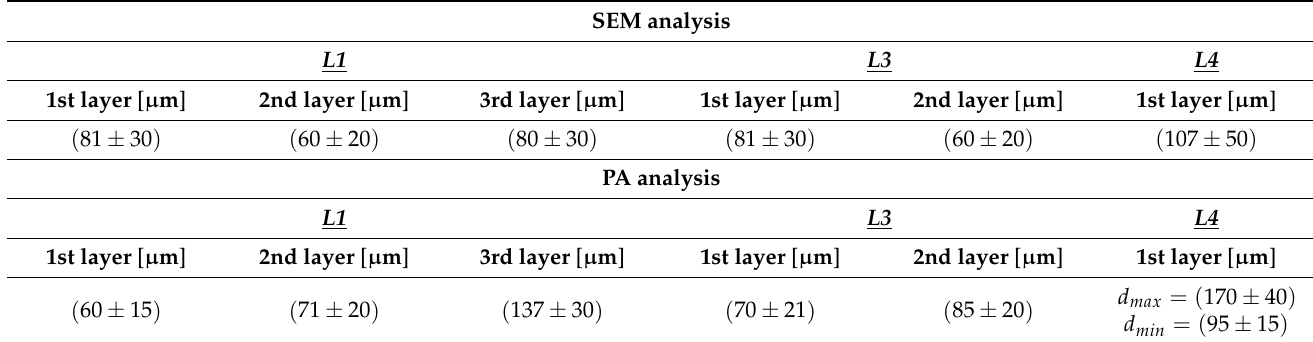
Table 2. Thickness measurements of different layers of fresco samples by SEM and PA imaging. SEM